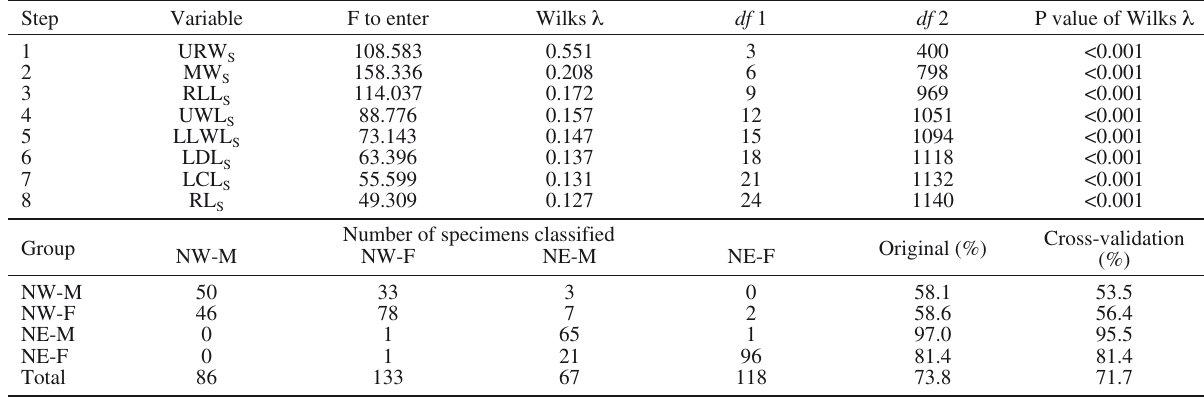
Table 9. – Coefficients of parameters in classification functions us- ing beaks and statoliths as